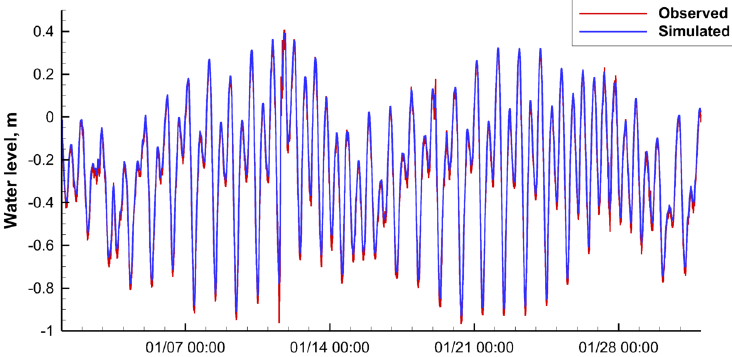
Figure 7. Comparison of simulated (hindcast) and observed water levels at Naples station for tidally-dominated flow.